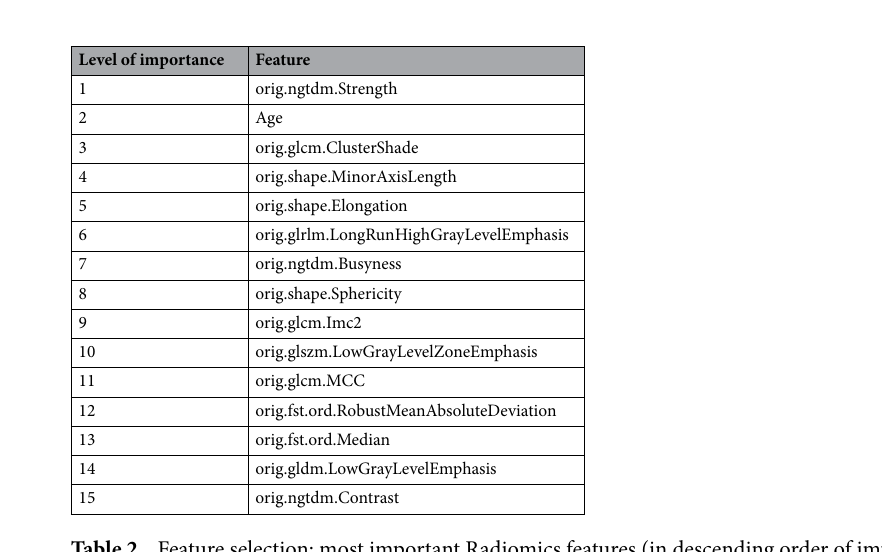
Table 2. Feature selection: most important Radiomics features (in descending order of importance).